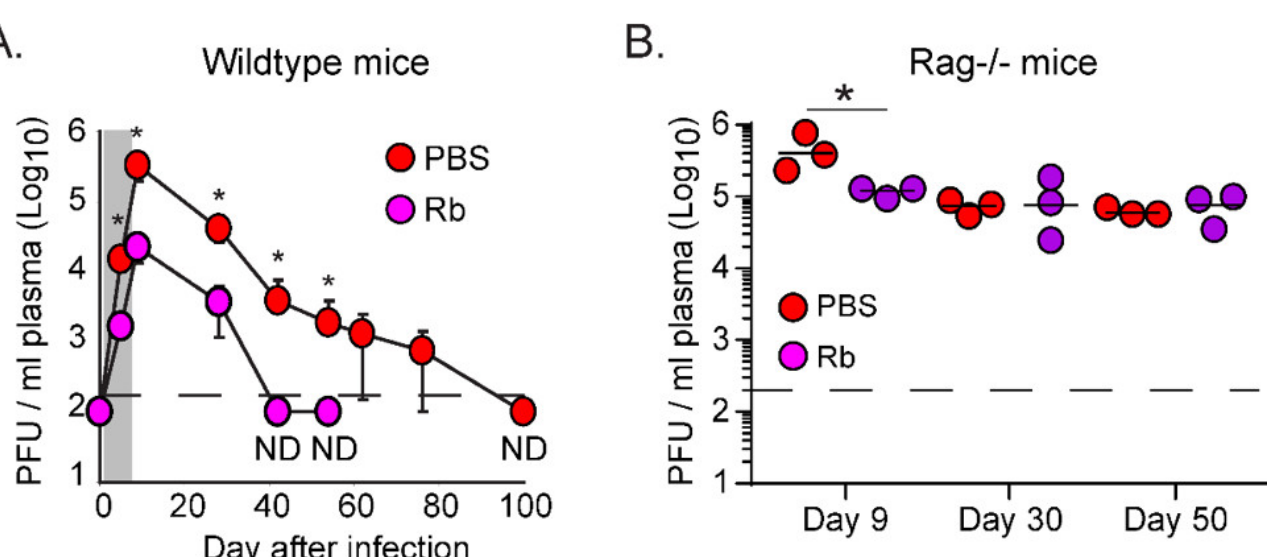
Figure 1. Accelerated control of chronic viremia following Rb therapy is dependent on adaptive immune responses. ( A ) Plasma viral titers from LCMV-Clone 13 (Cl13) infected C57BL/6 mice either PBS contro-treated (red circles) or treated with Ribavirin (Rb; purple circles) were determined at the indicated time point. Data are expressed as PFU per milliliter of plasma. Shaded area indicates time of Rb treatment (day 1–8 after infection). Each time point represents the average ± standard deviation (SD) of 4 mice per group. ND = not detected. ( B ) Infectious virus in the plasma of LCMV-Cl13 infected Rag−/− mice either PBS-treated or treated with Rb. Each circle represents a single animal. Data are representative of 2 experiments with 3–4 mice per group. * p < 0.05; one-way ANOVA.